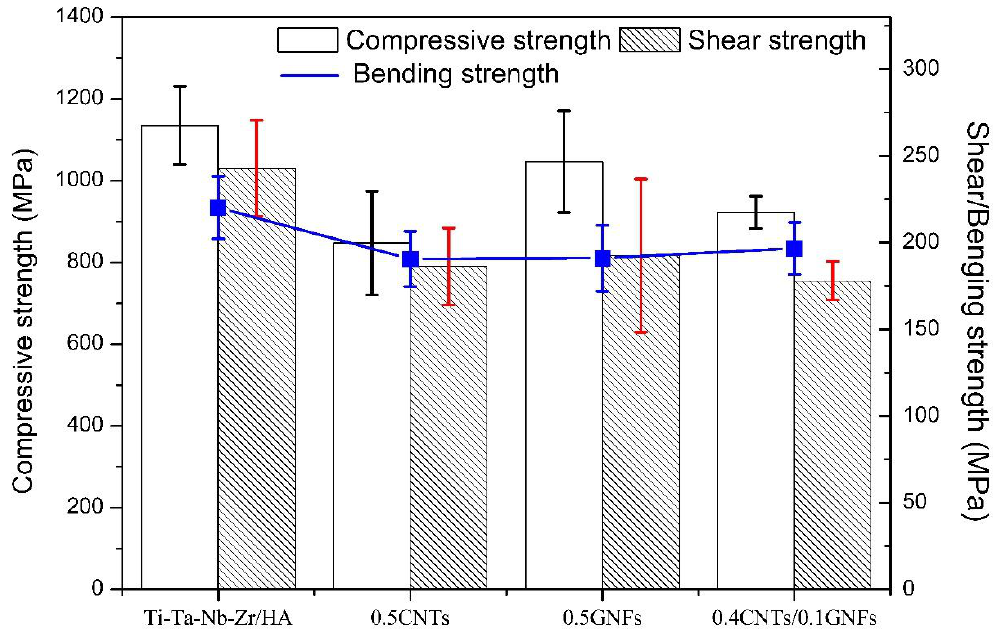
Figure 10. Compressive, shear and bending strength of the nanocomposites.